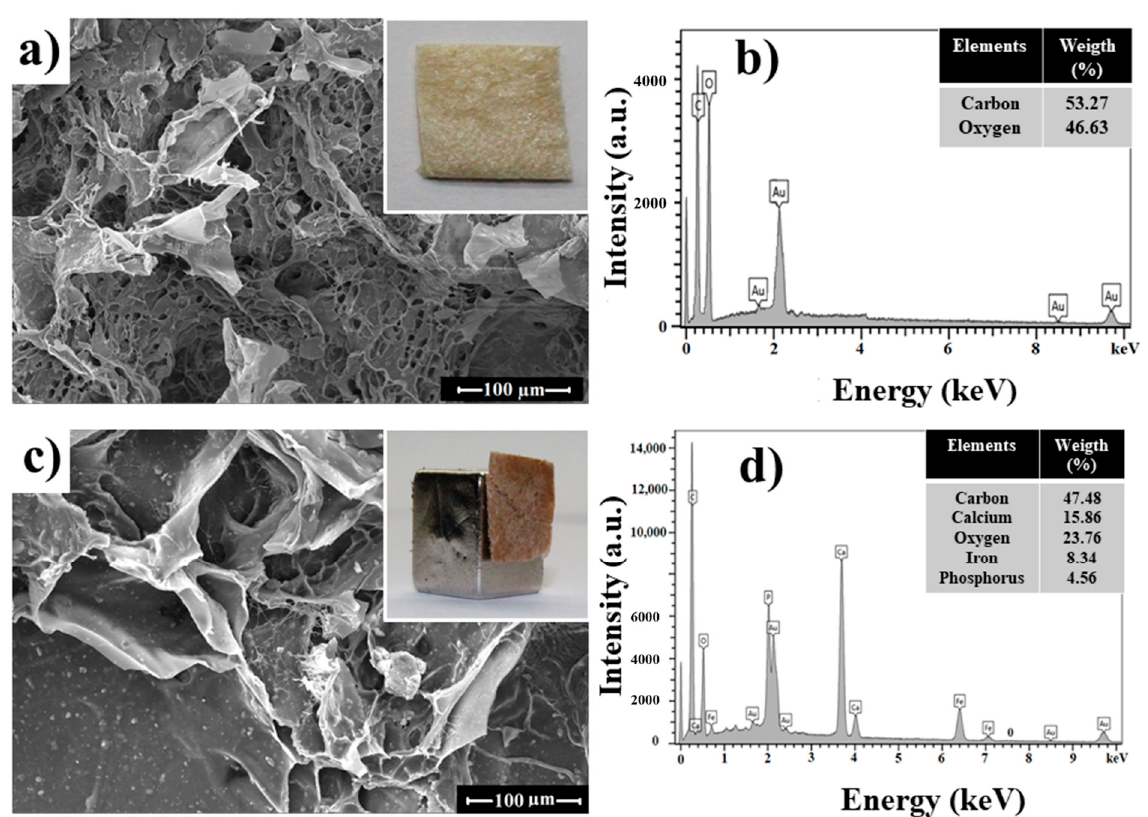
Figure 7. Scanning electron microscope images of ( a ) Pure CHI matrix, ( b ) Energy-dispersive X-ray (EDX) spectroscopy of pure CHI matrix, ( c ) CHI/Fe 3 O 4 —HA@AO-SIMV, and ( d ) EDX spectra of CHI/bionanocomposite with the respective elements and weight percentage.